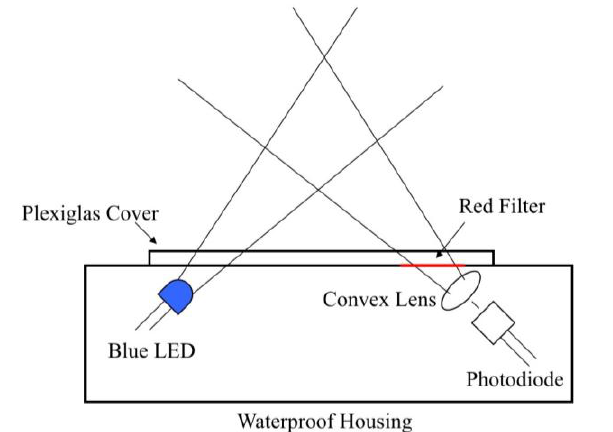
Figure 1 . Sensor components and geometry. The detector is placed at 90° to the light source to minimize the amount of excitation light scattered toward the detector.